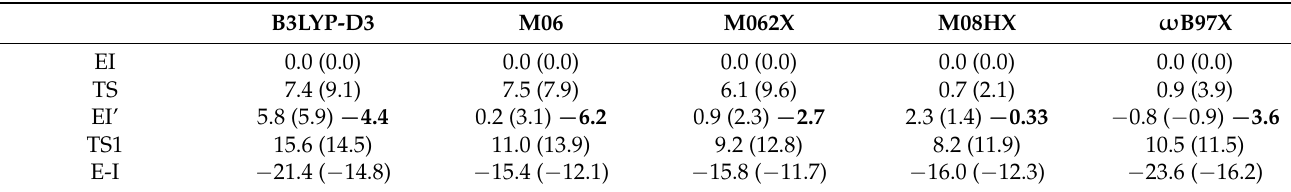
Table 1. Gibbs free energies for M pro -HID inhibition promoted by EBS calculated as a single point on B3LYP-D3/6-31+G (2d,2p) optimized geometries in water (protein) environments. In bold, values are reported only in water, the corresponding ones for the EBS-OH inhibitor are related to the EI ‘complex for the M pro -HID-EBS-OH system. All values are in kcal mol − 1 . B3LYP-D3